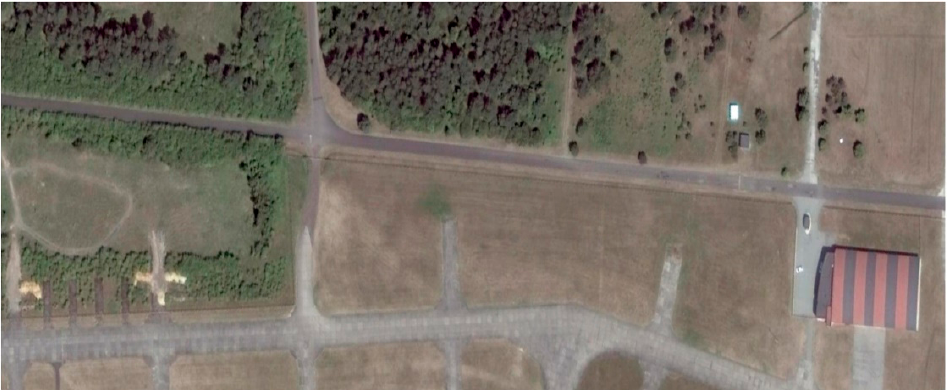
Figure 7. Aerial photography of the imaged area.